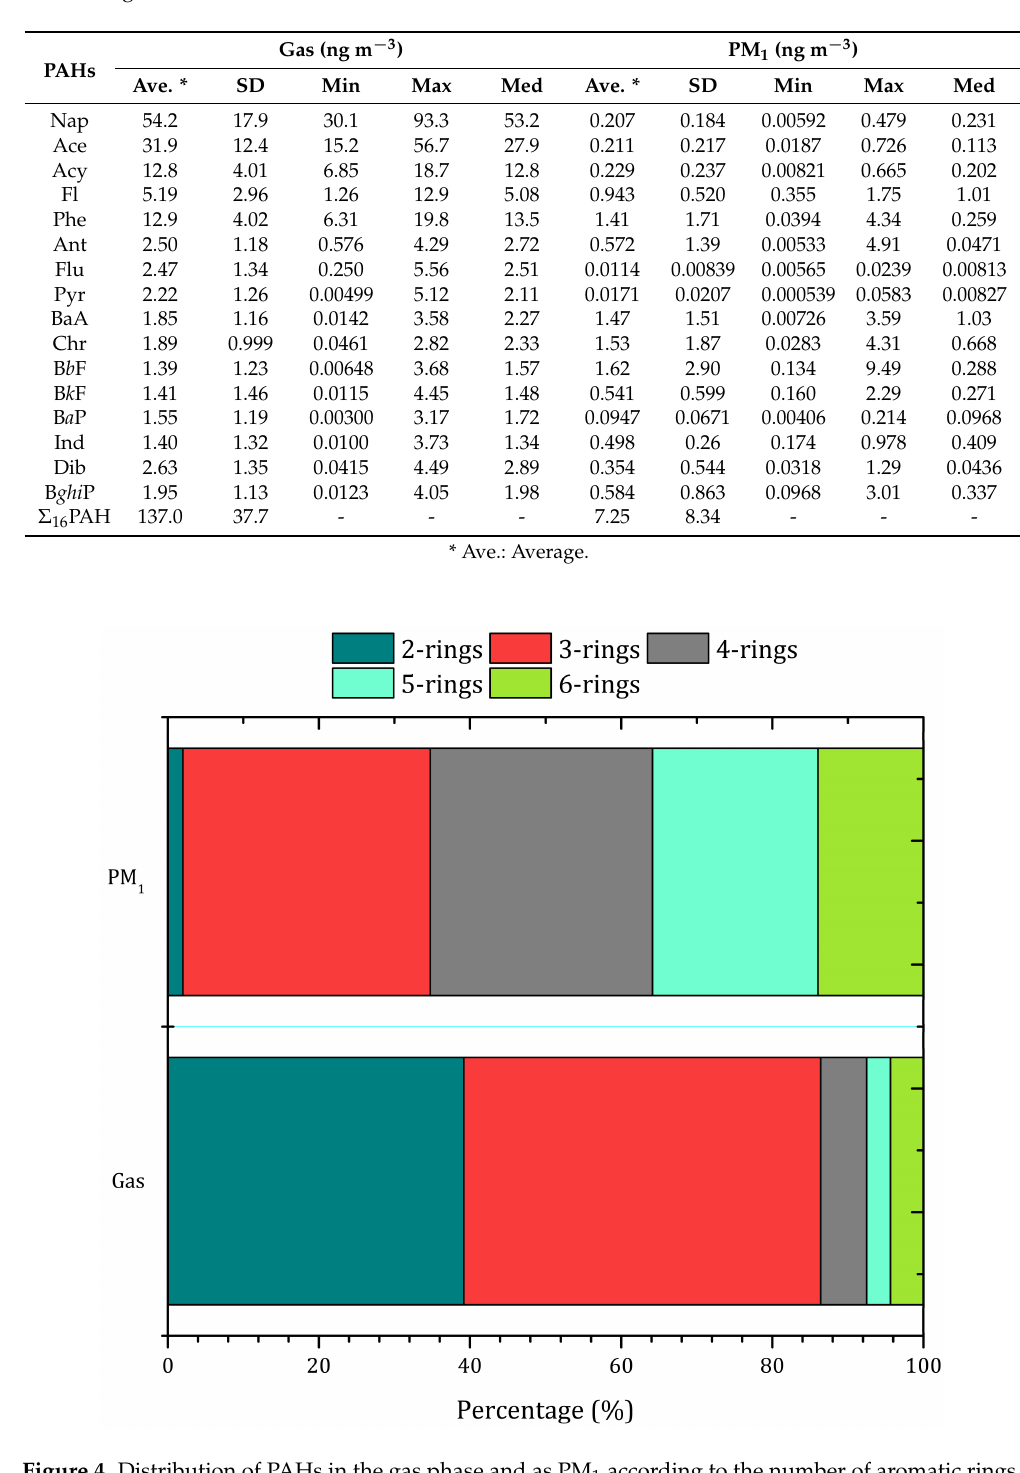
Figure 4. Distribution of PAHs in the gas phase and as PM 1 according to the number of aromatic